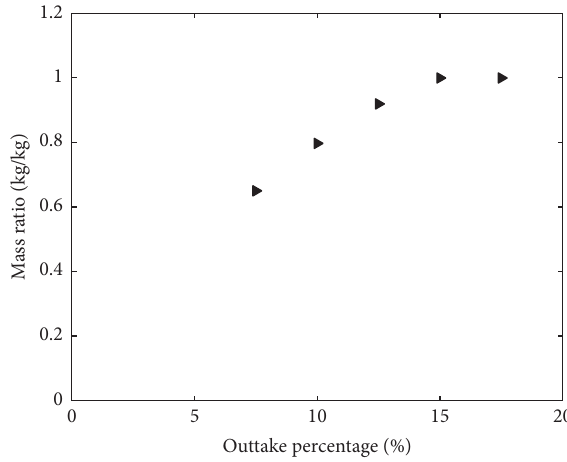
Figure 10: Mass ratio of evaporated water as a function of OP.